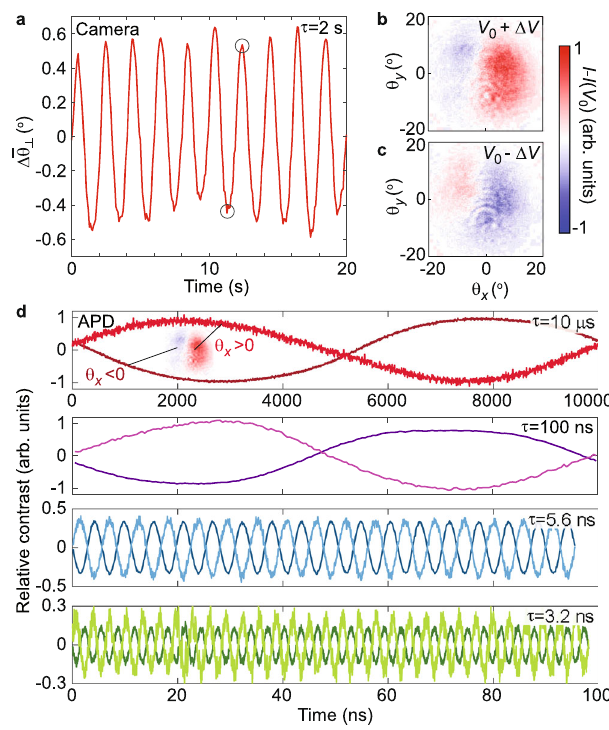
Fig. 4 High-frequency beam steering. a Oscillations of center-of-mass de fl ection ( λ 0 = 754.5nm) induced by oscillating back gate voltage (offset, V = 0.7 V; amplitude, Δ V = 0.45 V; period, τ = 2 s) and V 0 b , c Fourier plane images collected at V BG = V 0 + Δ V ( b ) and V = V − Δ V ( c ), as indicated by circles in a , after subtracting re fl ection BG 0 at V BG = V 0 . An inverted telescope was used to shrink the beam to simplify the subsequent APD measurements. d Photon count oscillations measured with APD at τ = 10 μ s, 100 ns, 5.6 ns, and 3.2 ns (top to bottom). Darker (lighter) shade curves show photon counts from left (right) side of Fourier plane, as indicated by the inset in the top panel. All curves are normalized to the corresponding contrast at τ = 10 μ